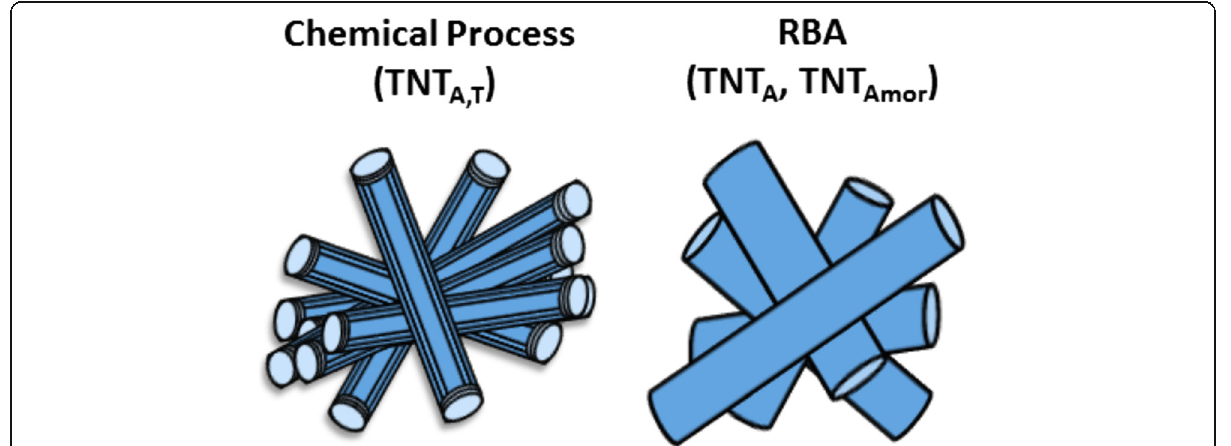
Fig. 1 Schematic illustration of TNT A,T , TNT A , and TNT